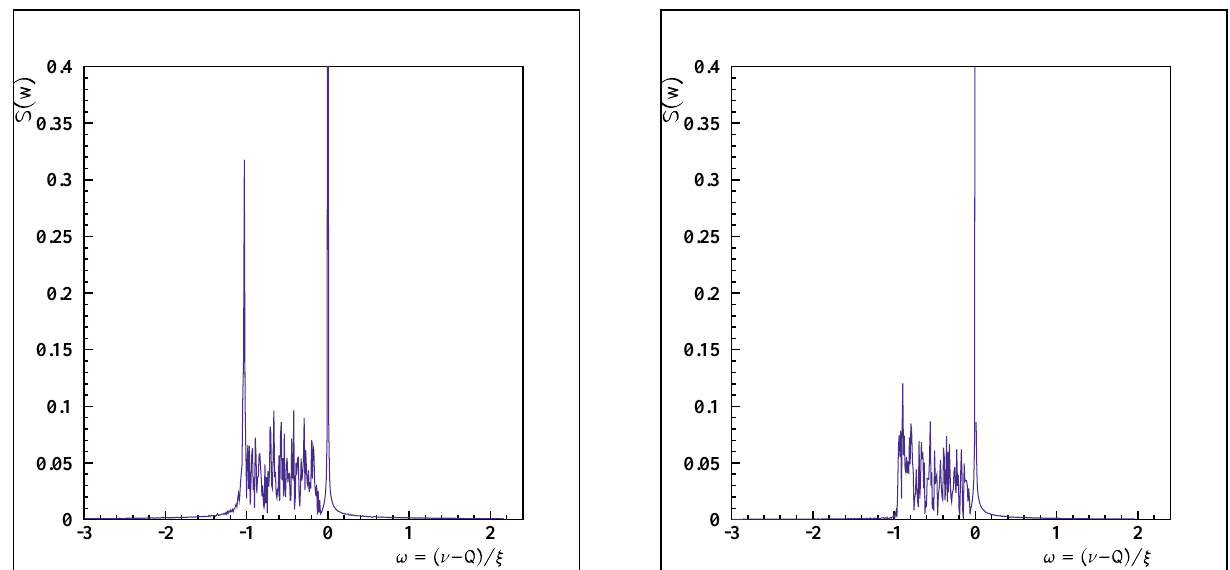
FIG. 4. (Color) Frequency spectrum of the bunch centroid motion (over 2 17 turns, N (cid:1) 10 4 macroparticles) for round beams and intensity ratio R I (cid:1) 0.65 (left) and 0.55 (right).